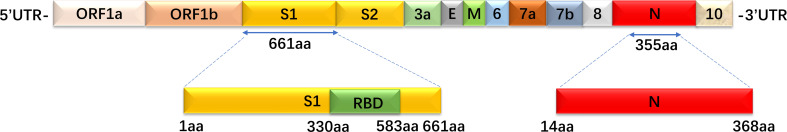
The recombinant S1, RBD, and N protein amino acid position mapping. These three proteins were used as coated target antigens to establish indirect ELISA to detect IgG antibody levels against SARS-CoV-2.